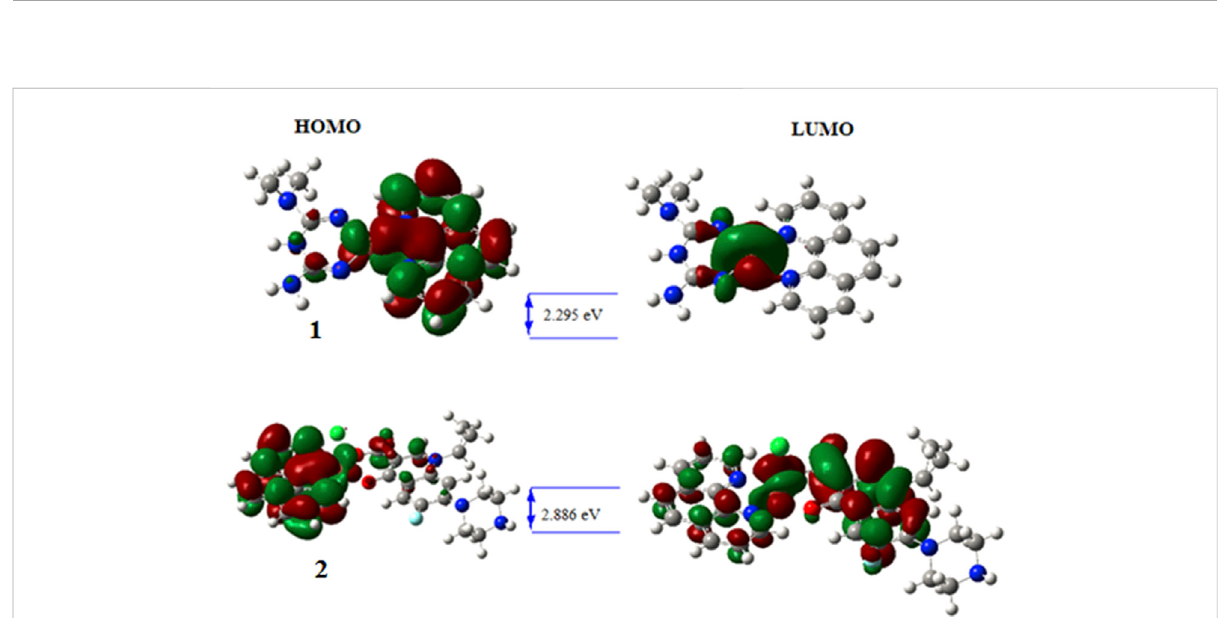
FIGURE 5 HOMO — LUMO distribution and band gap energy of the synthesized metal